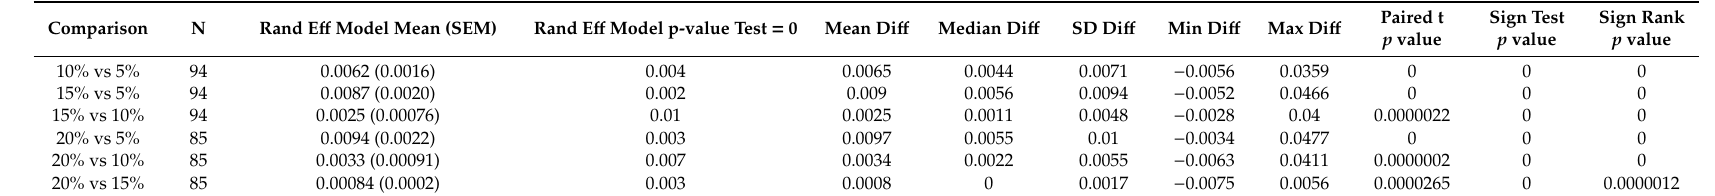
Table A3. Random E ff ects model testing di ff erences between